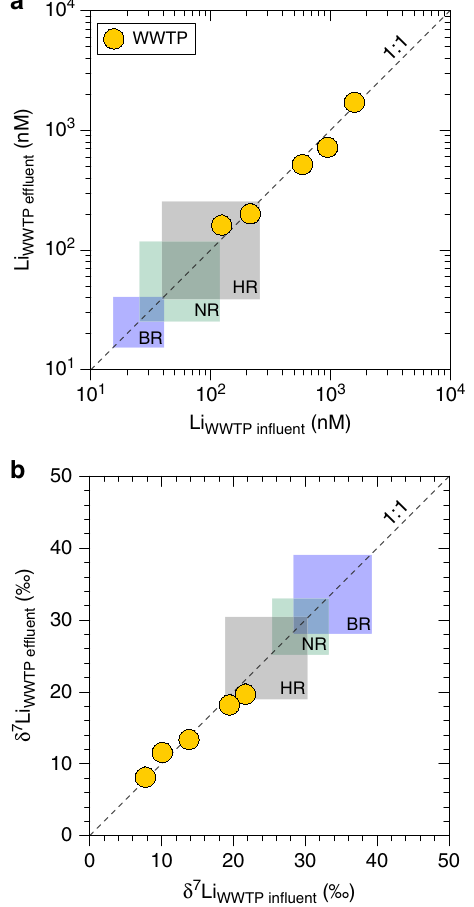
Fig. 3 Lithium relationships in wastewaters. Li concentrations a and Li isotope compositions b of wastewater fl owing in (in fl uent) and fl owing out (ef fl uent) of wastewater treatment plants (WWTP, yellow circles). For comparison, the range of values obtained for the Han River and tributaries are also given (in